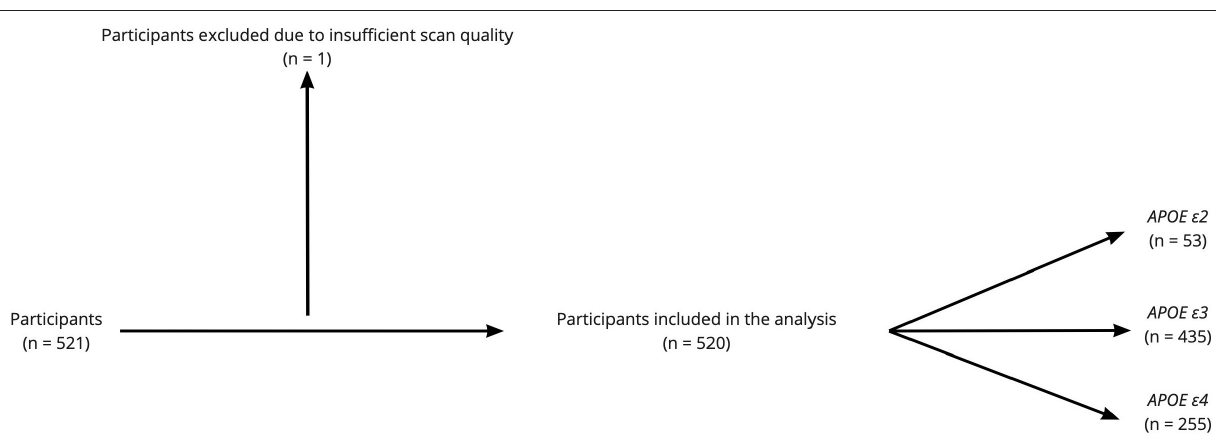
19%), MCI (3T: 32% and SWI: 16%), SCI (3T: 28% and SWI: 17%), VaD (3T: 27% and SWI: 18%), and other dementias (3T: 32% and SWI: